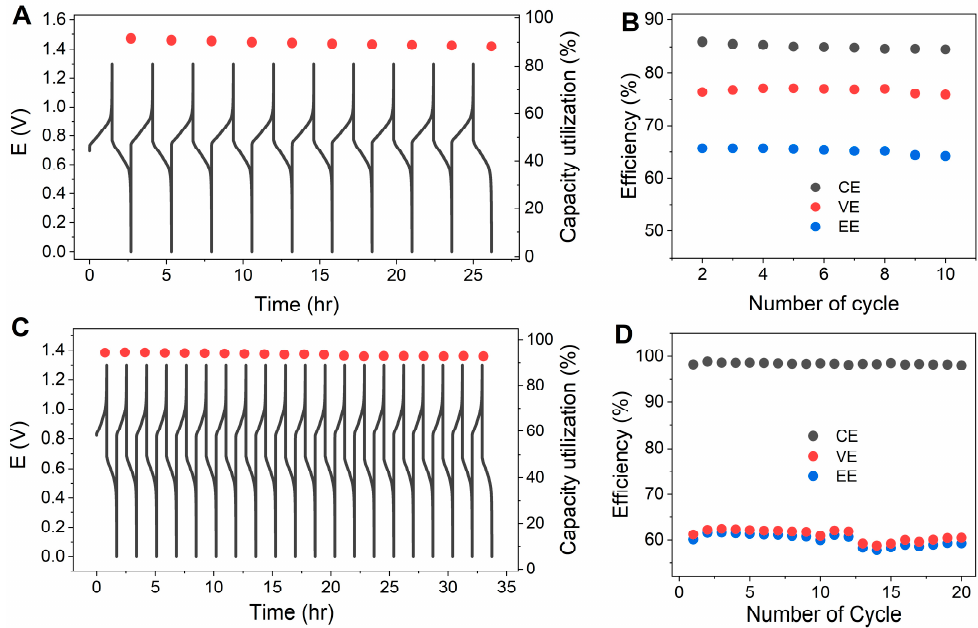
Figure 7. ( A , C ) Charge–discharge curves for constant current cycling of ABRFB at 0.1 A cm − 2 using ASM as a negolyte; capacity utilization is indicated for each complete cycle. Flow field—flow through, Membrane—Nafion 211 ( A ) or Nafion 117 ( C ), flow rate—100 mL min − 1 , ( B , D ) Corresponding efficiencies for ABRFB using Nafion 211 ( B ) and Nafion 117 ( D ) membrane.